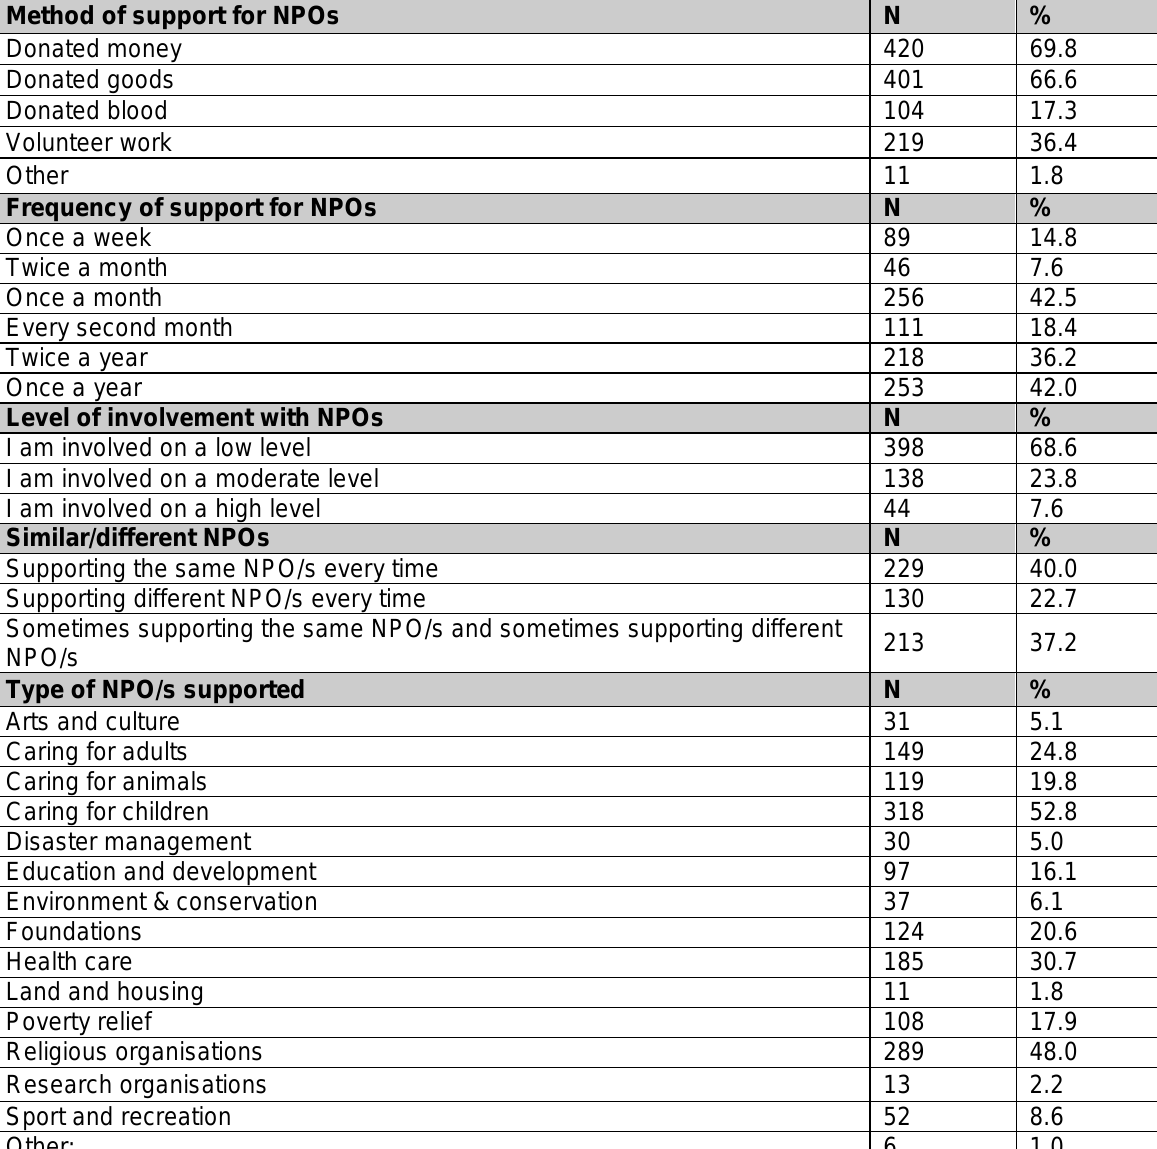
Table 1: Current supporting behaviour of respondents 1 Method of support for